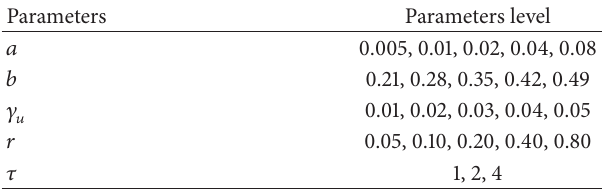
Table 1: Parameters and parameter level